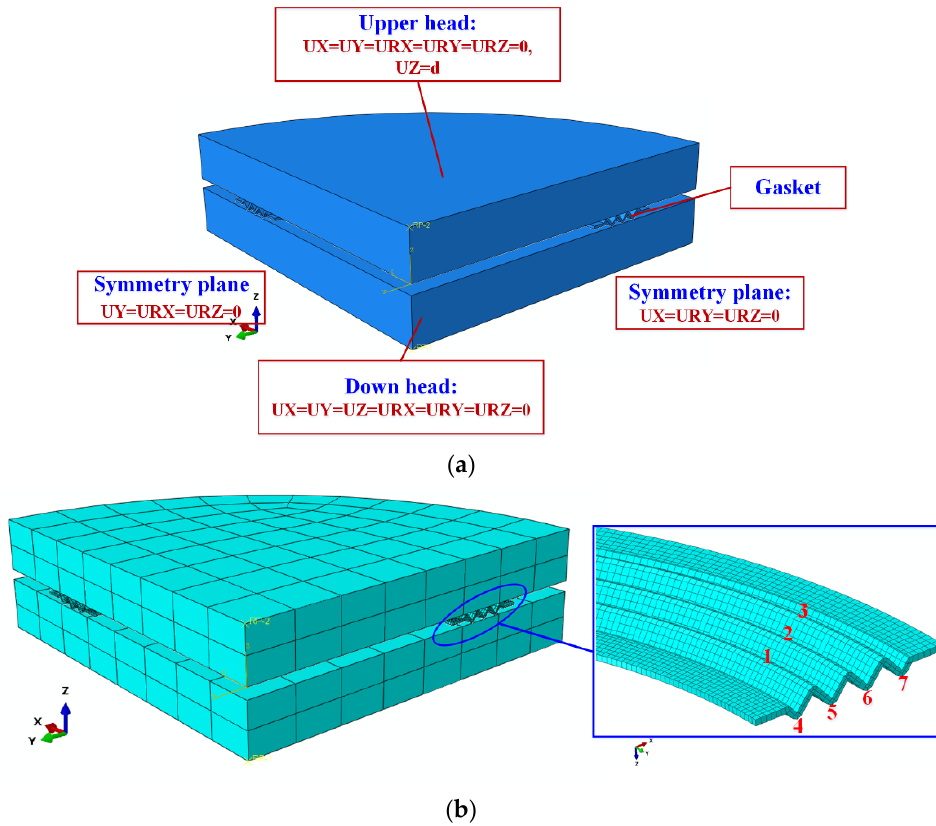
Figure 7. Finite element analysis model of mechanical properties of NiTi alloy corrugated gasket: ( a ) Boundary conditions; ( b ) Mesh model.